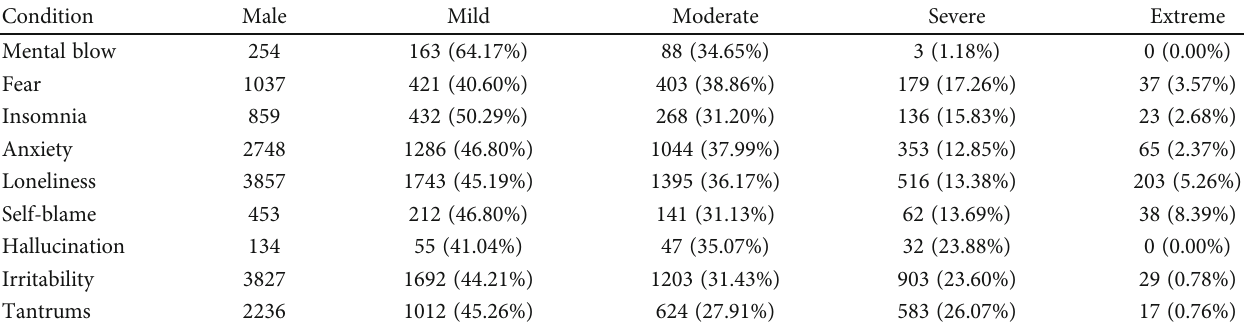
Table 2: Statistics of psychological conduction of undergraduate students from the university in Guangzhou.